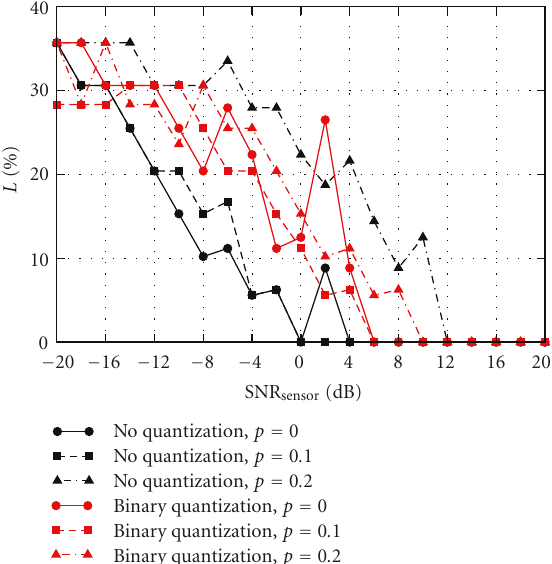
Figure 6: Percentage loss, as a function of the sensor SNR, in a scenario with N = 8 and simplified detection algorithm at the AP. Both absence of quantization and binary quantization at the sensors. Three values for p are considered: (i) 0 (ideal communication links), (ii) 0.1, and (iii)